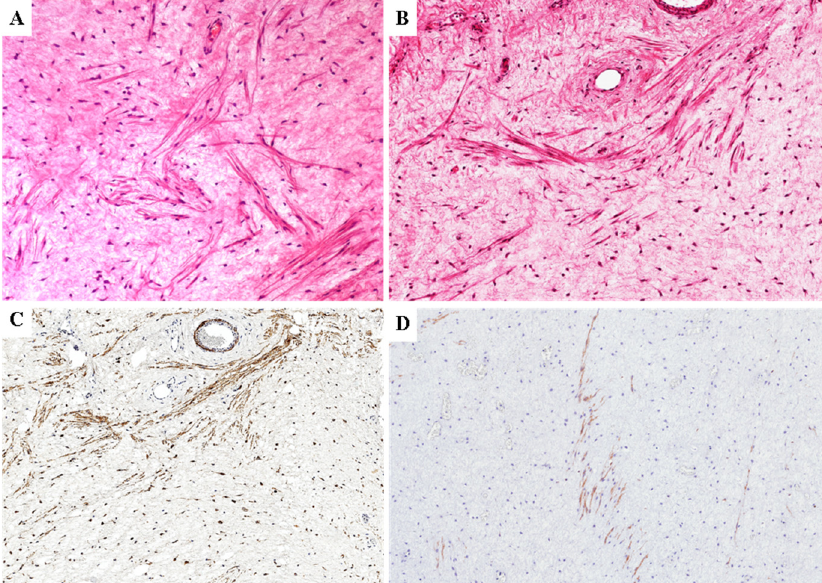
Figure 3. Smooth muscle cell differentiaton in classic-type primary DAM . ( A ) Isolated or small bundles of thin spindle-shaped cells with eosinophilic cytoplasm, which are interpreted as stromal cells with smooth muscle cell differentiation, are haphazardly scattered within the myxofibrillary stroma. ( B ) Occasionally, these spindle cells are found in proximity of blood vessels; however, an origin from the smooth muscle cell layer of the blood vessels cannot not be demonstrated. ( C ) Similar to the neoplastic stromal cells, even those with smooth muscle differentiation are stained with desmin. ( D ) Only stromal cells with smooth muscle differentiation are stained with h-caldesmon.